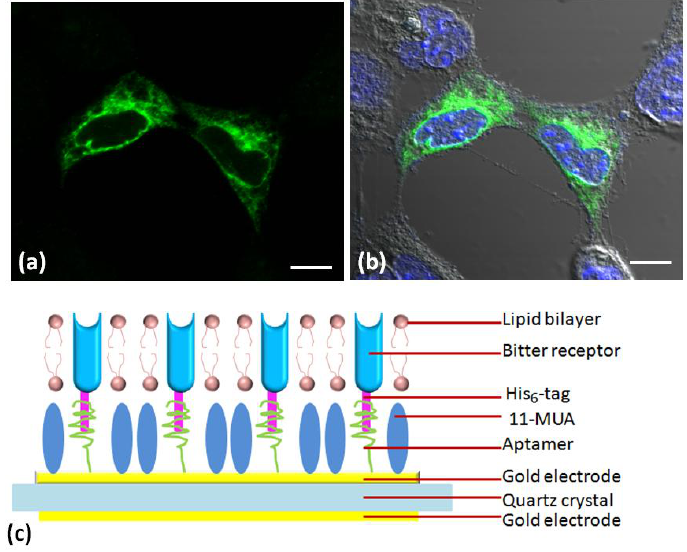
Figure 6. Expression of taste receptors in HEK-293 cells indicated by ( a ) fluorescent image and ( b ) combination of fluorescent and bright-field images; ( c ) Schematic diagram of taste receptors coupled with the gold electrode surface of QCM devices via self-assembled aptamers [94].